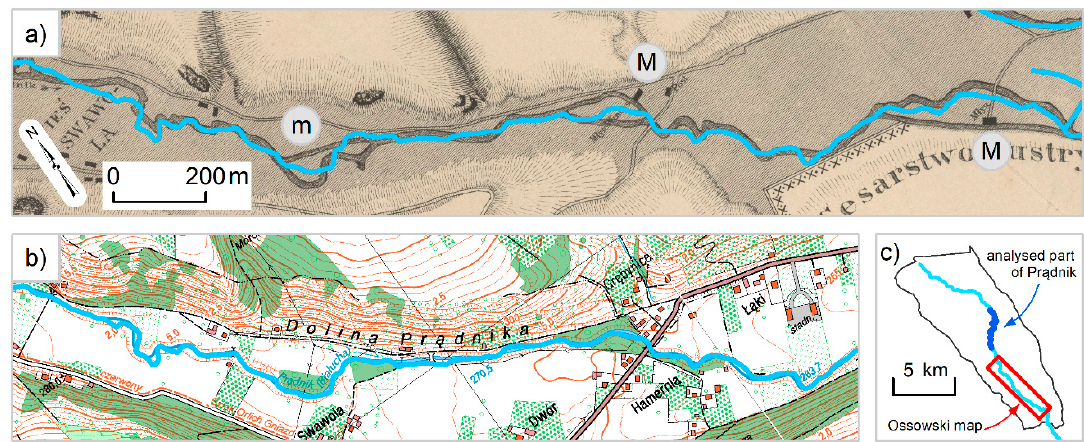
Figure 5. Map by Godfryd Ossowski (a) in comparison to contemporary topographic map 1:10,000 (b) and the Ojców National Park (ONP) watercourses layer and also the main part of the Pr ą dnik River, analysed in this article (c). M—Mill with a millrace, m—millrace.